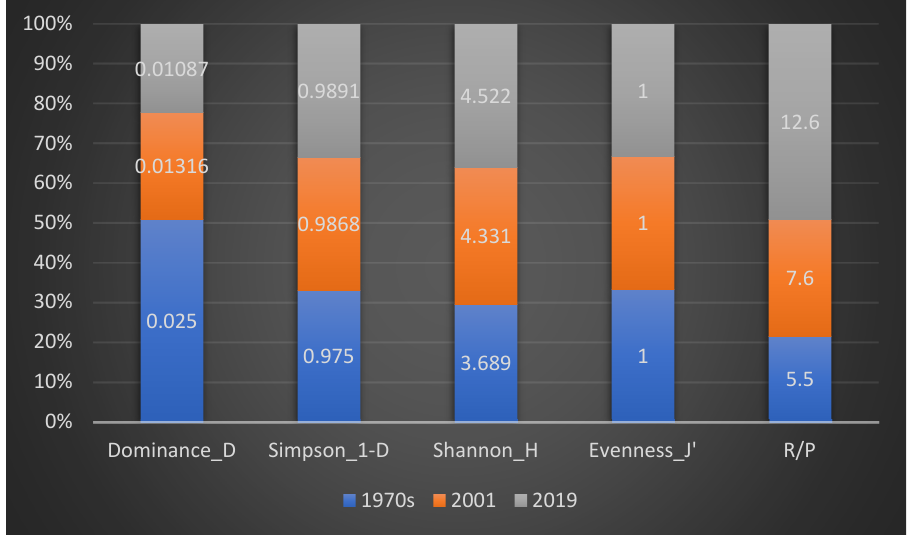
Figure 7. Values of Simpson’s Dominance index (D), Simpson’s index (1-D), Shannon’s index (H) Evenness index (J’) and R/P index in the coralligenous macroalgal assemblages of the 1970s, 2001, and 2019.